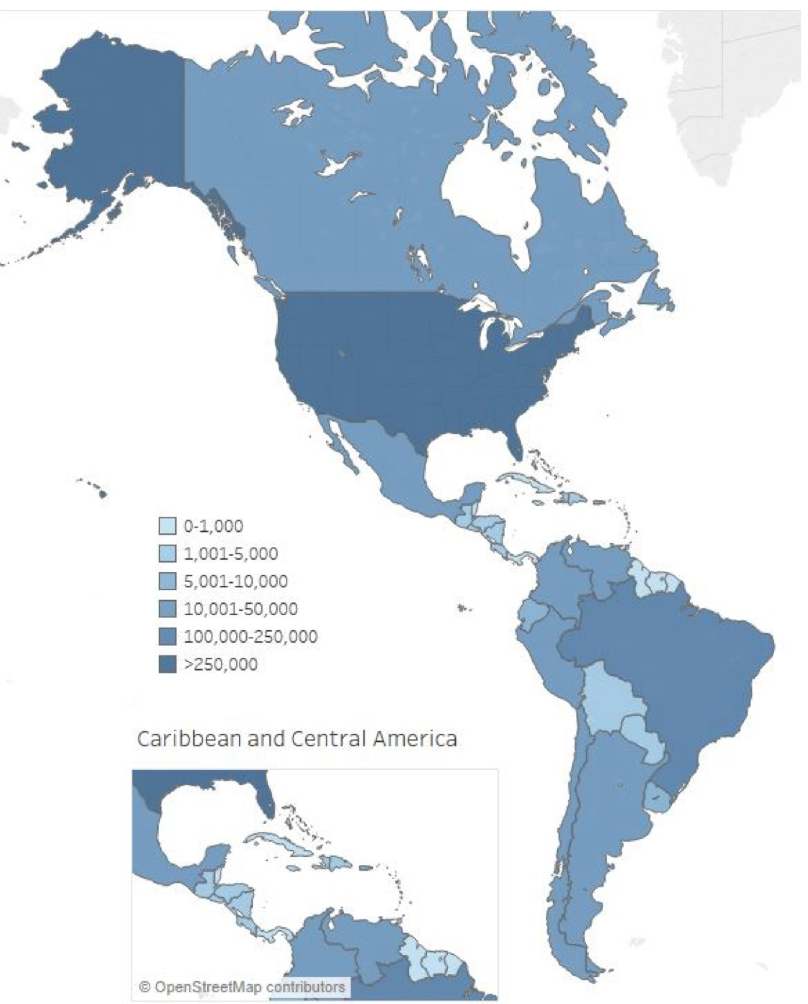
Fig 2. Estimated annual number of influenza-associated respiratory hospitalizations by country in the